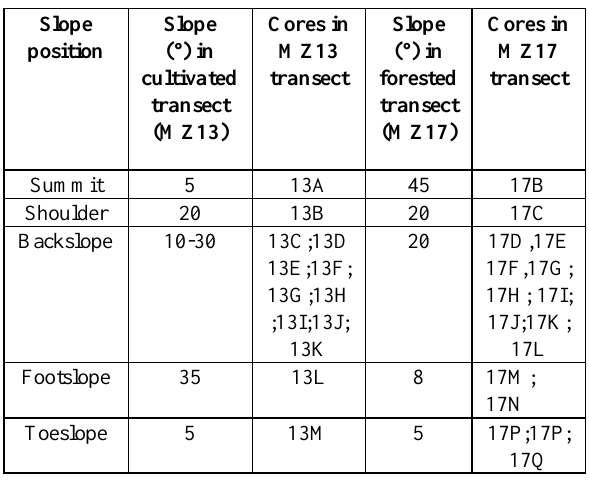
Table 1. Slope position of different cores selected in the